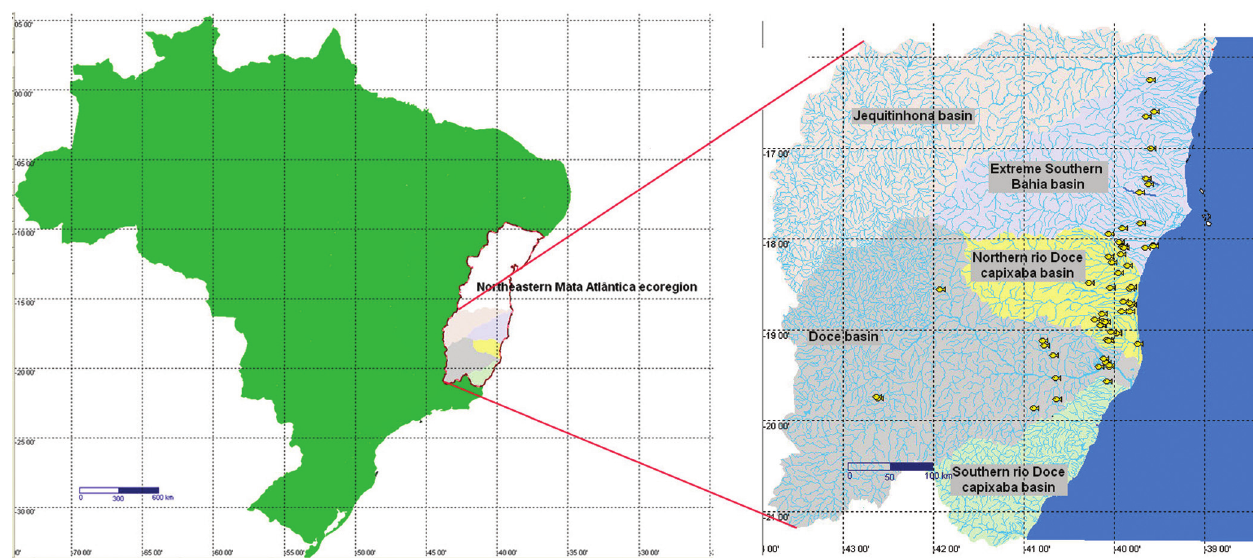
Fig. 6. Distribution of Moenkhausia doceana in Northeastern Mata Atlântica ecoregion. Each mark may represent more than one